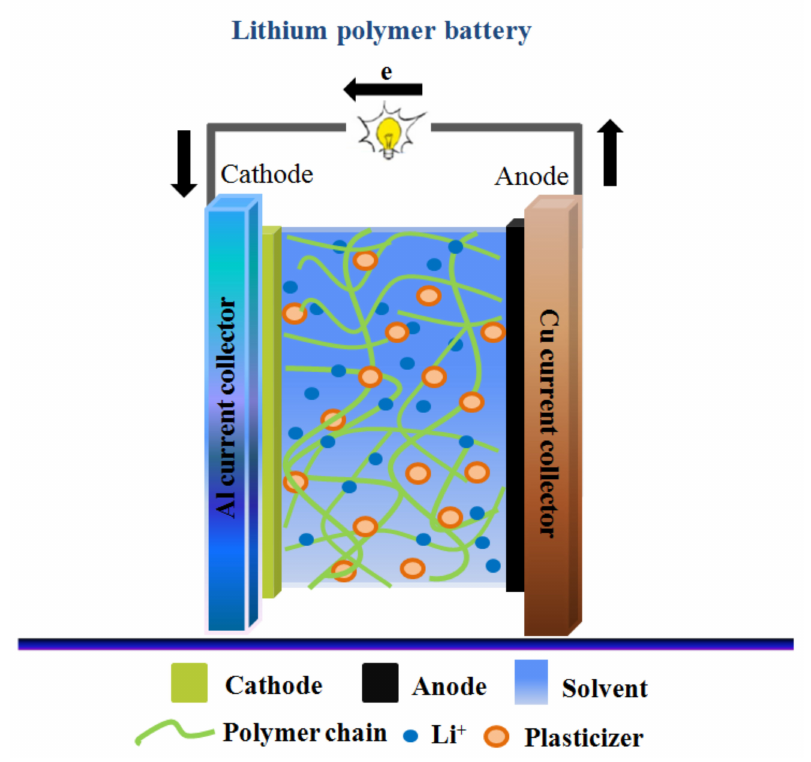
Figure 2. Schematic of a lithium polymer battery based on